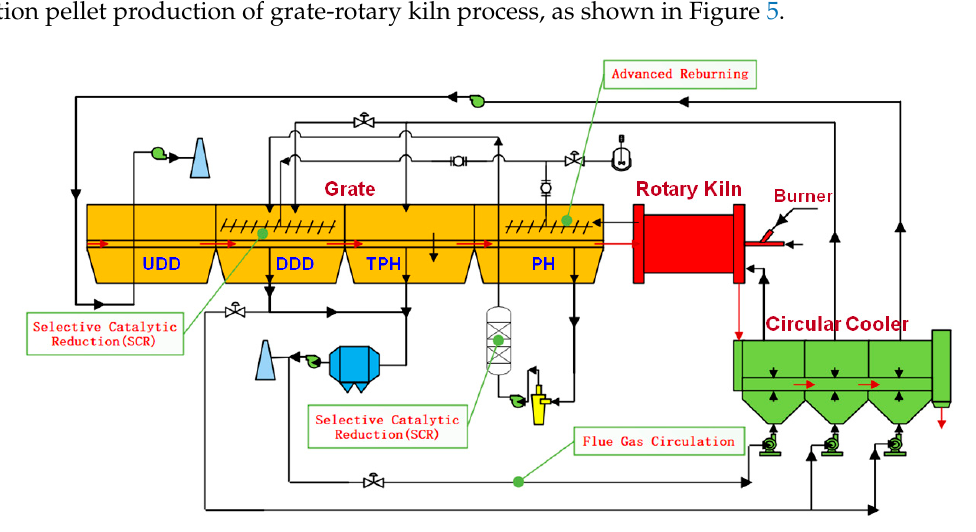
Figure 5. Denitrification mechanism of advanced reburning technology.